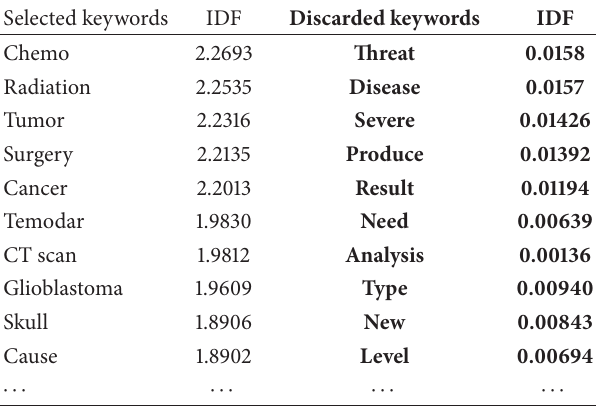
Table 1: IDF scores of sample keywords of the